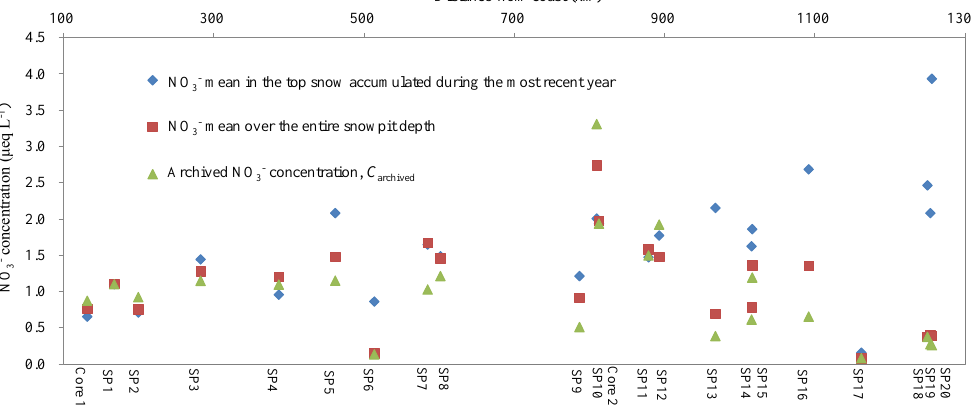
concentration, C archived , in triangle). 3